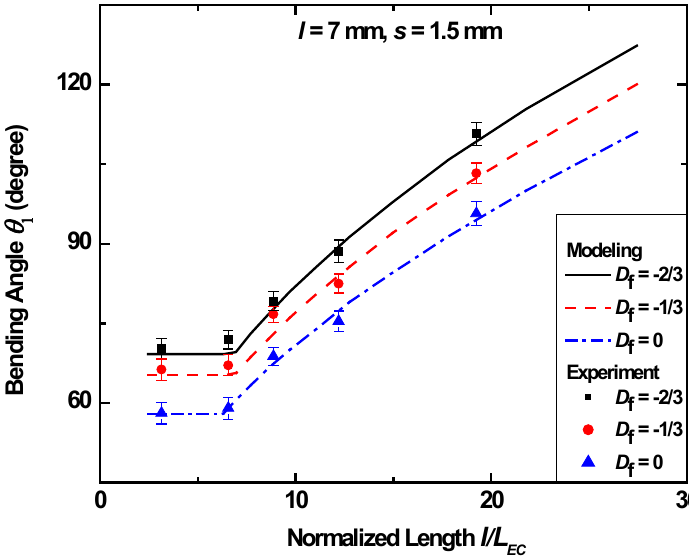
Figure 7. Modeling and experimental results of the bending angle of the membranes ( l = 7 mm, s = 1.5 mm) in contact with featureless flat surfaces. The results are shown as a function of the normalized membrane length for different deployment factors.